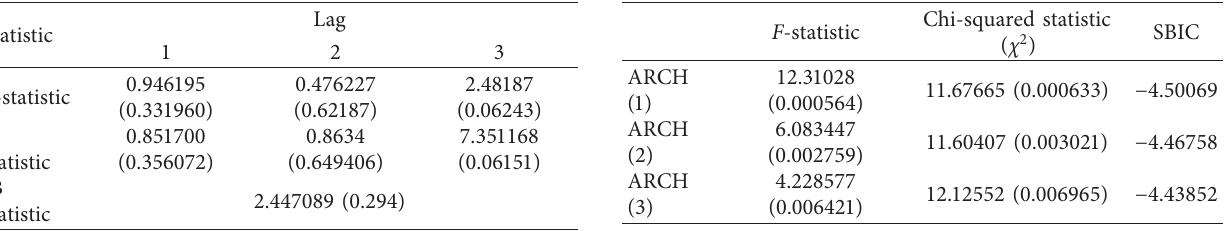
Table 5: ARCH effect test using LM test for squared residuals of the fitted models for conditional